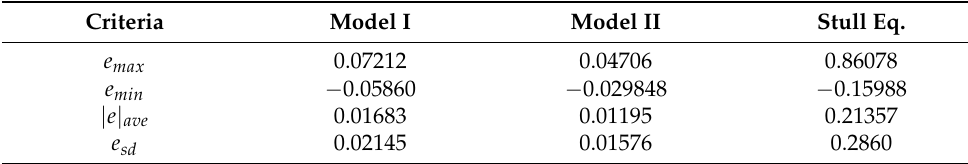
Table 1. The criteria for the predictive errors for three equations.